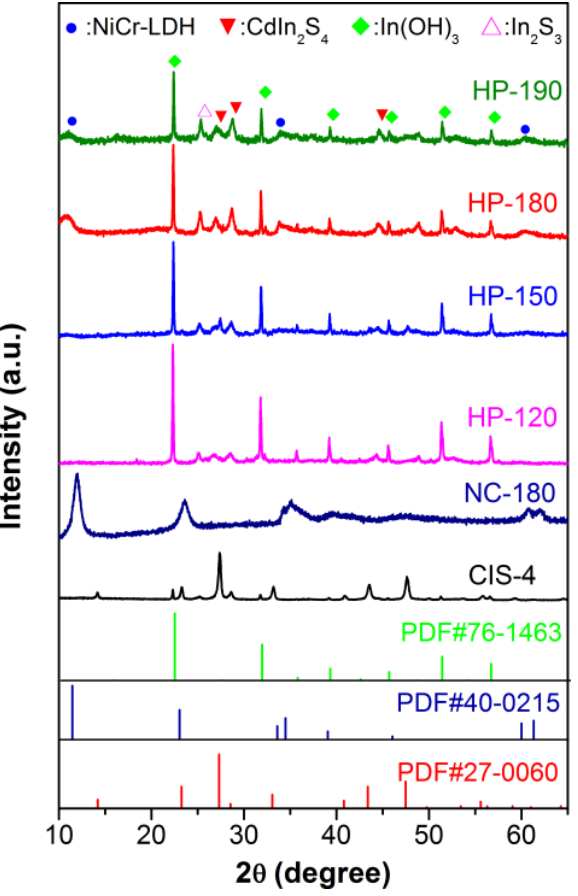
Figure 1. XRD patterns of HP ‐ 120, HP ‐ 150, HP ‐ 180 and HP ‐ 190 together with NC ‐ 180 and CIS ‐ 4. Figure 2a–c display SEM images of CIS-4, NC-180 and HP-180, respectively. CIS-4 exhibited an octahedral morphology with small flakes and particles on the surface, while pristine NiCr-LDH showed an irregular shape with an aggregated sheet-like structure. In comparison, the HP-180 photocatalytic system revealed an interwoven-sheet structure composed of nanoflakes. Figure 2d showed SEM EDX mapping. It revealed that Cd, In, S, Cr and Ni elements are homogeneously distributed in HP-180. O is detected in the whole analyzed area but its distribution is less even. This result was confirmed by TEM observation. In the HRTEM image in Figure 3c and Figure S3b, the lattice spacing of 0.33, 0.28 and 0.37 nm correspond to (311), (220) and (006) crystal planes of CdIn 2 S 4 , In(OH) 3 and NiCr-LDH, respectively. In Figure 3d, the lattice spacing of 0.21 and 0.40 nm correspond to (511) and (200) crystal planes of CdIn 2 S 4 and In(OH) 3 , respectively. In Figure S3b, the lattice spacing 0.26 nm corresponds to (012) crystal plane of NiCr-LDH. The HRTEM observation suggested the formation of a composite photocatalyst with multiple intimate-contact interfaces, which could facilitate the transfer and separation of charge carriers across the